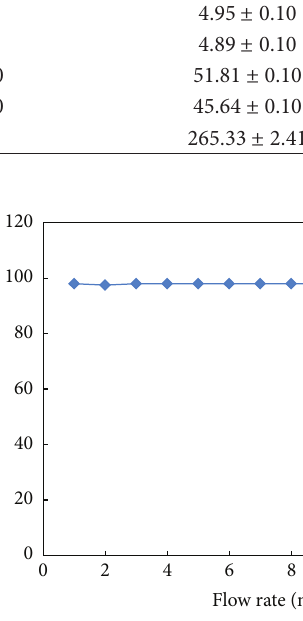
F 5: Effect of �ow rates of sample solutions on the percent recovery of Au(III) by 9-acridinylamine alumina.